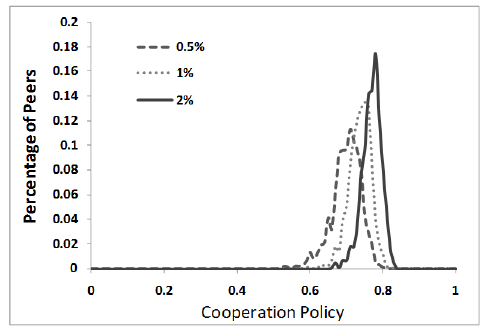
Fig. 7. Probability distribution of the cooperation policy, set by individual peers after 20